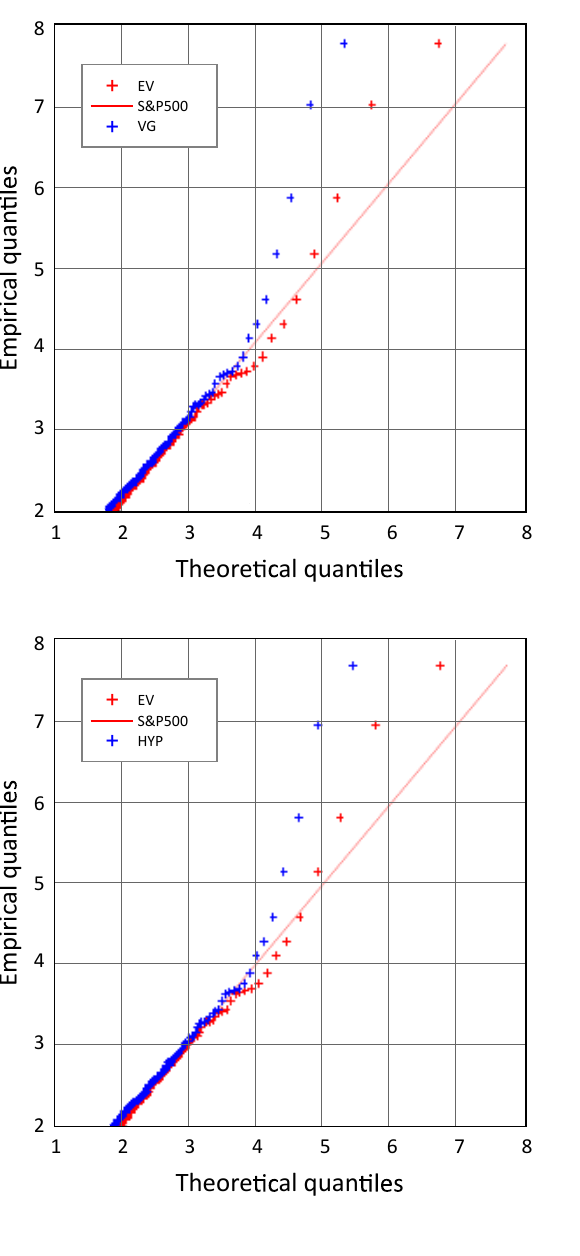
Figure 1. Conditional and unconditional quantiles in excess of threshold (2): long position in S&P